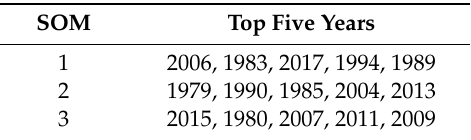
Table 1. The first five years used for composite analysis after selection from the detrended time series of occurrence frequencies for each SOM.